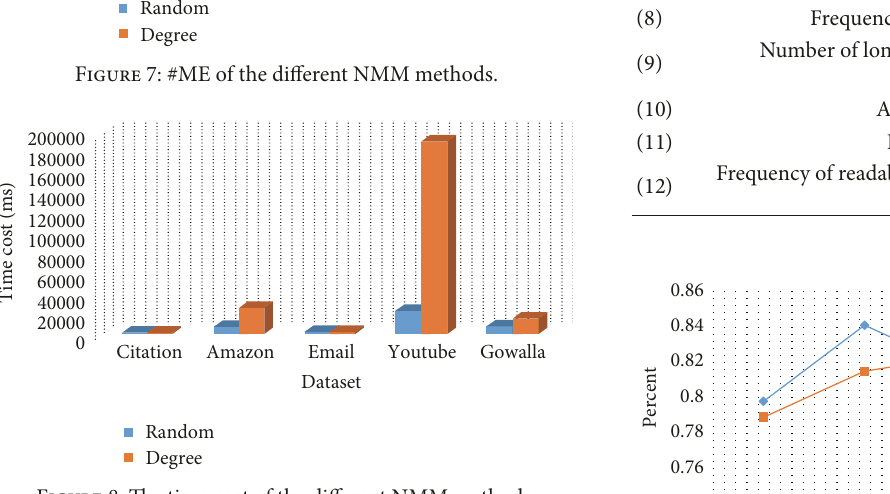
Figure 8: The time cost of the different NMM methods.